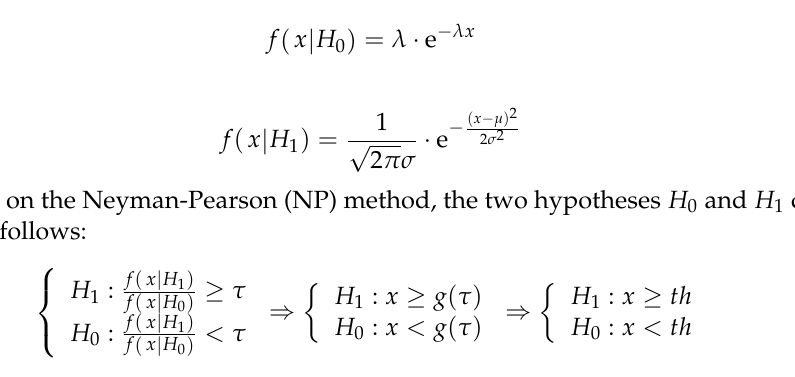
distance is 45~105 cm. For each distance from 45 cm to 105 cm with step of 10 cm, we use different